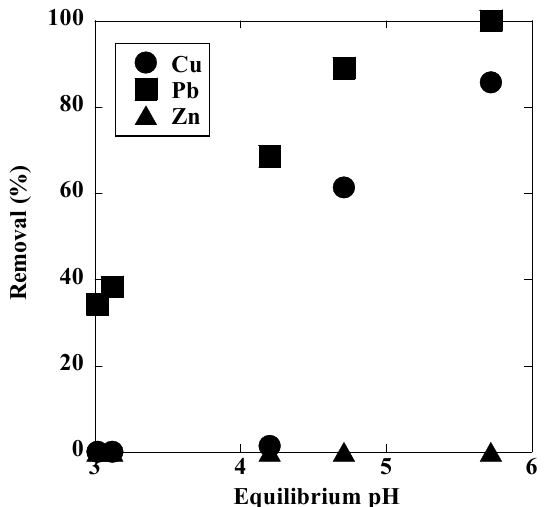
Figure 9. Removal of Product-K 2 S obtained at 300 °C for Pb 2+ , Zn 2+ , and Cu 2+ from the mixed solution.